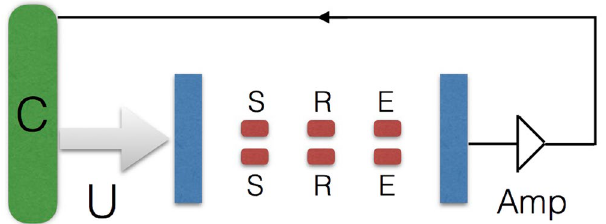
Figure 5. Scheme of the proposed implementation. In the most complex example proposed, we consider 6 superconducting qubits inside a 3D cavity, distributed in two rows along the cavity axis (another possible configuration would be with two 3-qubit columns perpendicular to the cavity axis). Amp denotes the amplification process, while C represents the controller device, and U is a local operation on the qubits conditional on the classical feedback